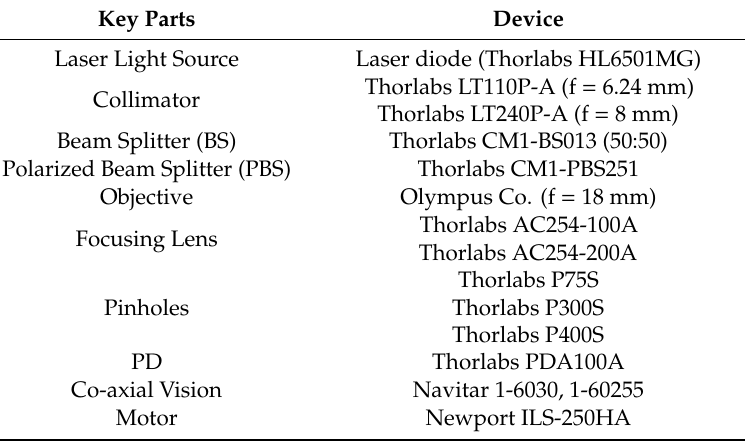
Figure 3. Schematic illustration of our proposed dual-confocal system. Table 2. Devices used in our proposed system.